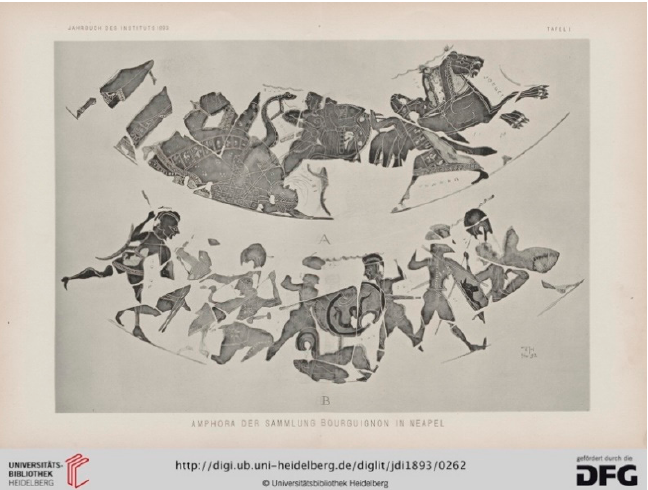
Figure 9. Drawing of scene of the murder of Eriphyle and a battle scene from a Tyrrhenian black- figure amphora (formerly SMB inv. no. 4841); attr. to the Tyrrhenian Group; Attica (from Orvieto); ca. 550 BCE . [Drawing from (Hauser 1893), pl. 1. Image © Universitätsbibliothek Heidelberg